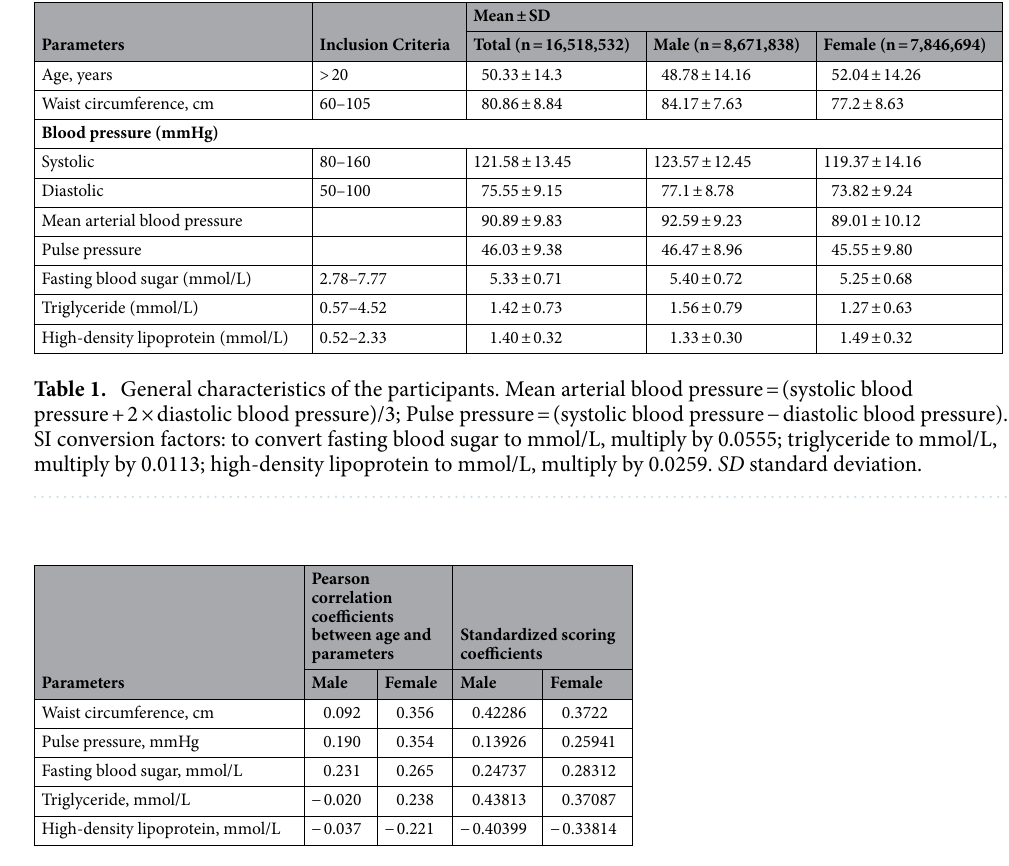
Table 2. The parameters influencing metabolic syndrome BA. PP (Pulse pressure) = systolic blood pressure − diastolic blood pressure. All parameters are P < 0.001.